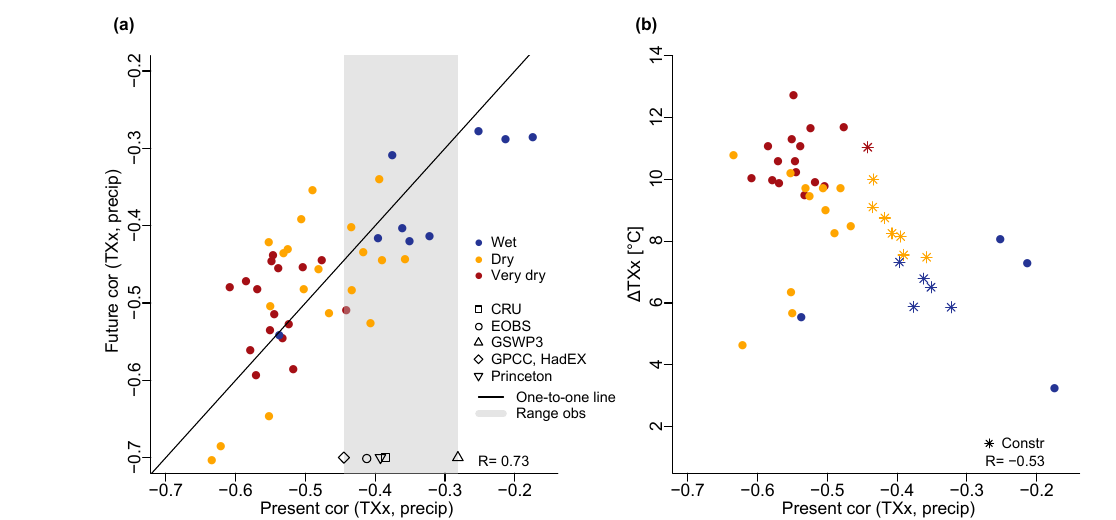
Figure 5. (a) Future vs. present-day cor(TXx, precip) for wet (blue), dry (orange), very dry models (red) and for observations. The one- to-one line is shown in black. The gray background depicts the minimum and maximum from the distribution of cor(TXx, precip) of the observational datasets. (b) The projected increase in TXx vs. present-day cor(TXx, precip). The stars indicate the models within the constrained ensemble, the colors refer to the three model subgroups as in (a)